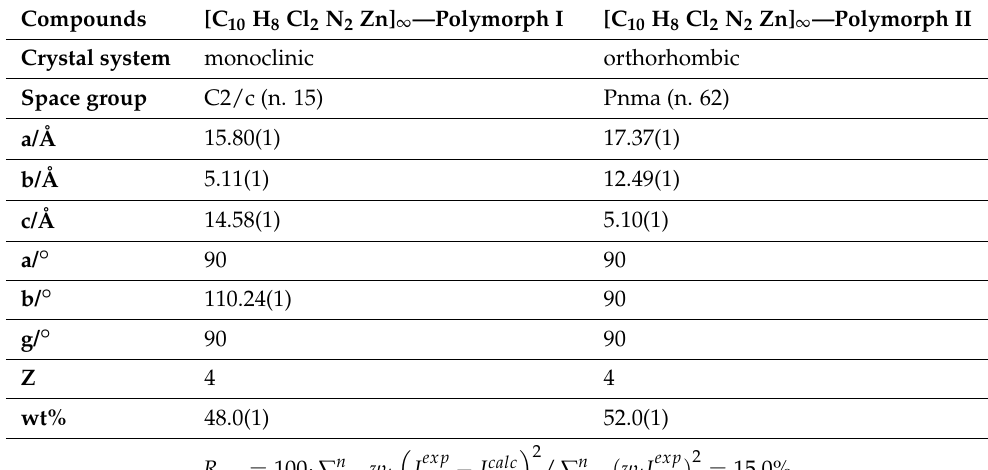
Table 1. Summary of X-ray powder data and structure refinement parameters for compounds obtained by sonochemical method.